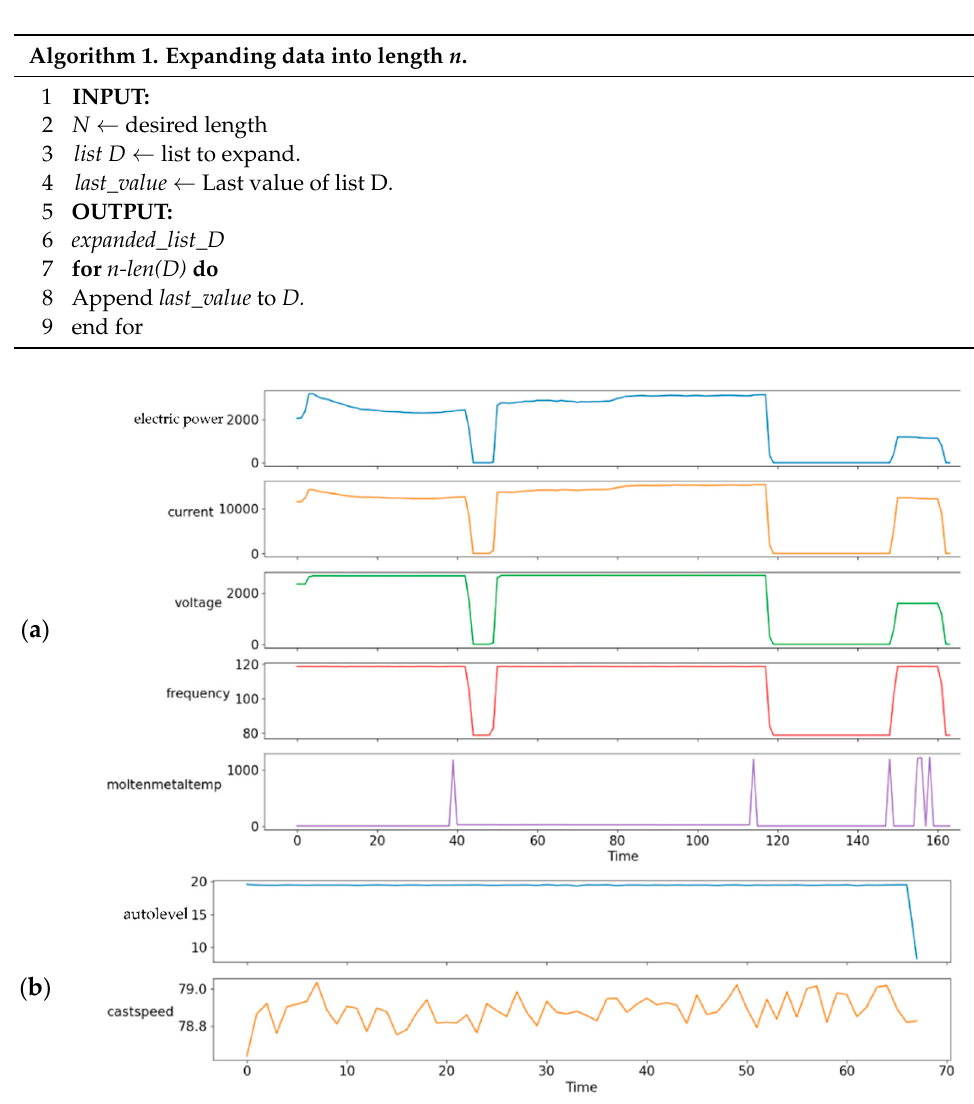
Figure 9. Detailed visualization of extracted TSWP: ( a ) melting process and ( b ) casting process.